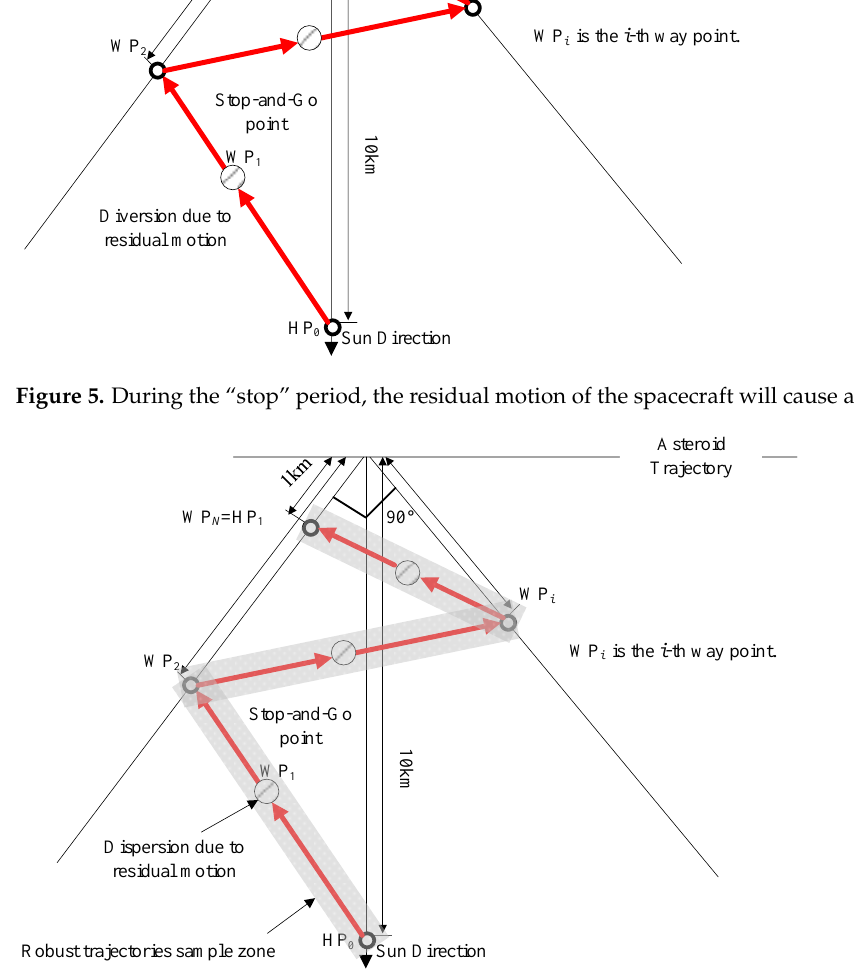
Figure 6. The drift during “stop” period will cause the subsequent trajectory to deviate from the original trajectory, and this deviation will continue to diverge through error propagation.